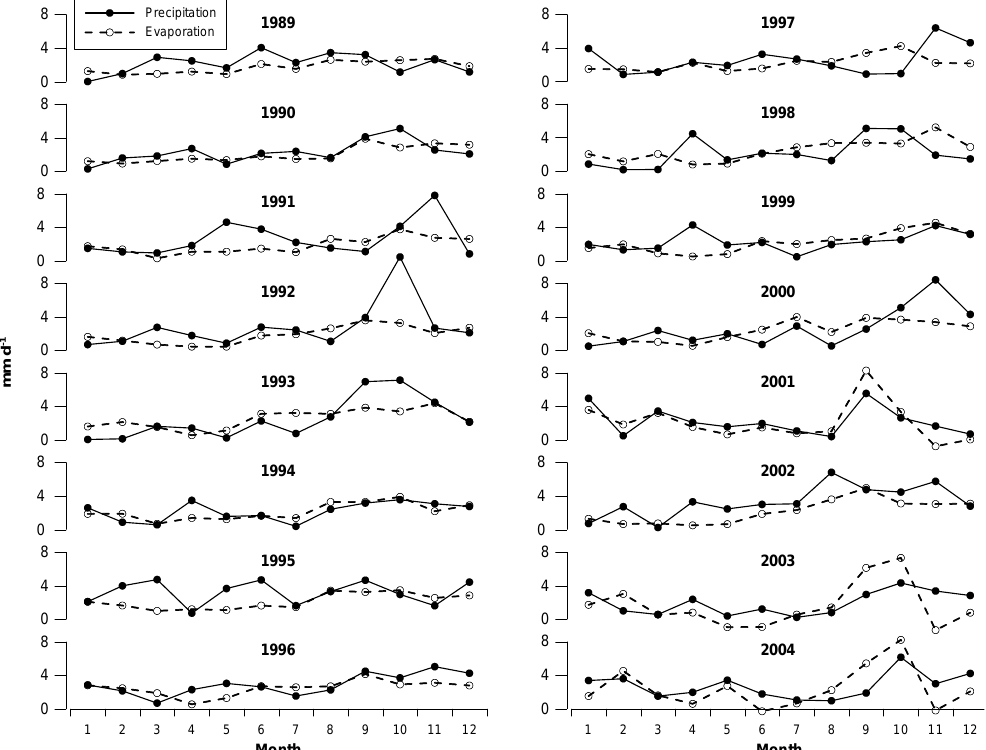
Figure 6. Monthly averages of precipitation (full line with black dots) and evaporation (dashed line with white dots) at the Po River delta– Rovinj profile in the analysed years